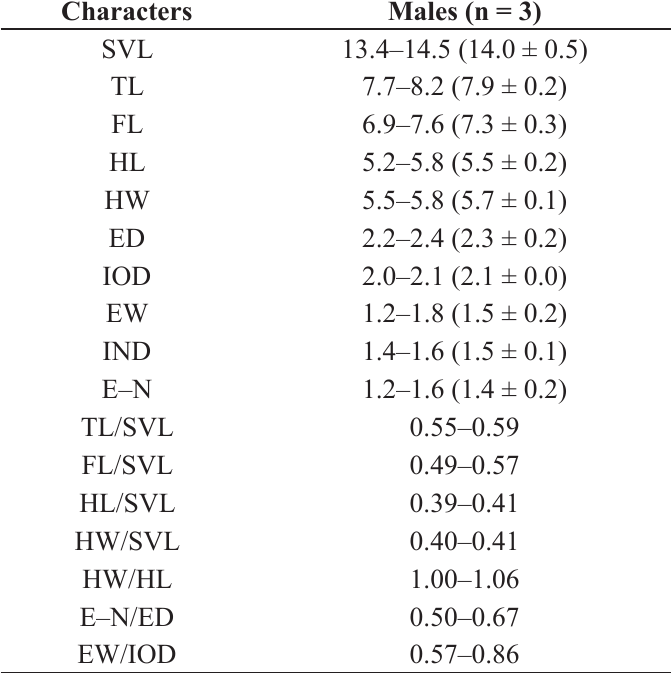
Table 4. Measurements (in mm) and proportions of the male type series of Pristimantis boucephalus sp. nov.; ranges followed by means and one standard deviation in parentheses. For other abbreviations see Materials and